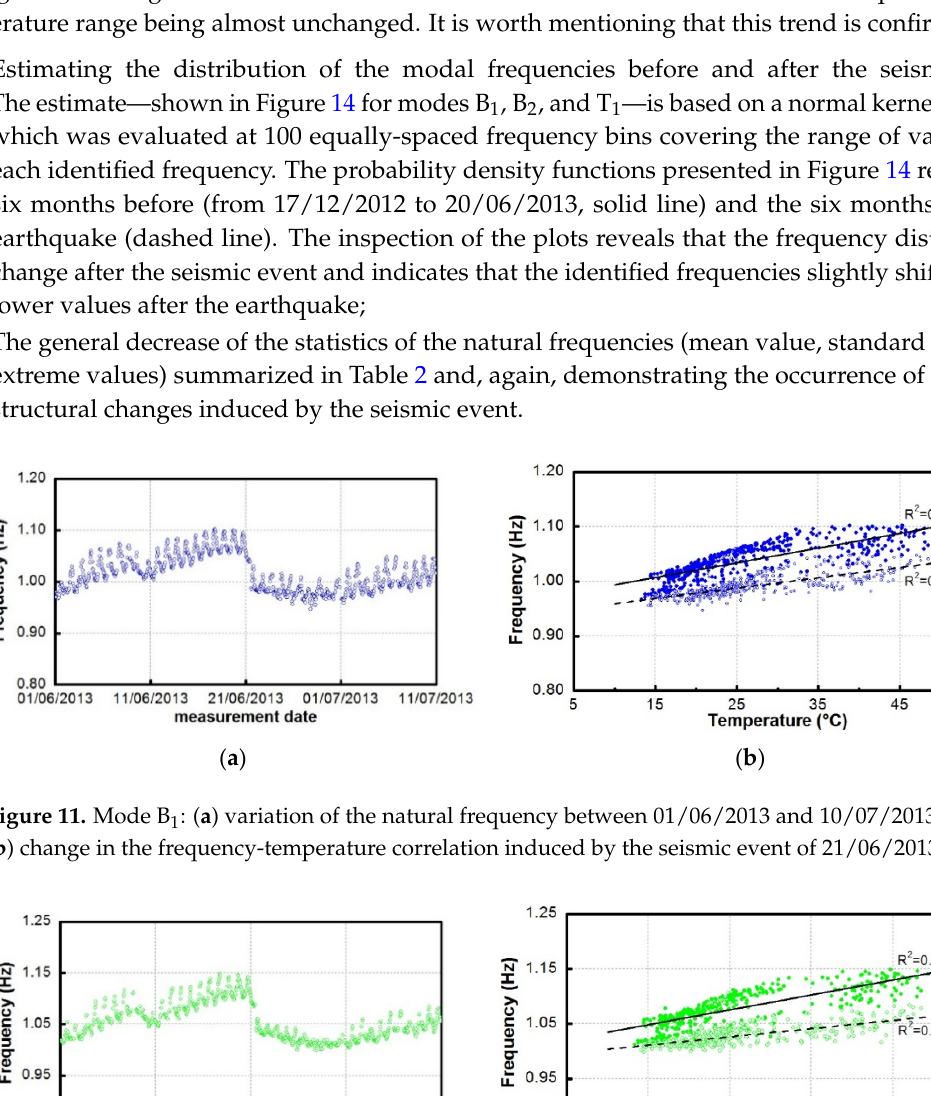
Figure 12. Mode B 2 : ( a ) variation of the natural frequency between 01/06/2013 and 10/07/2013; and ( b ) change in the frequency ‐ temperature correlation induced by the seismic event of 21/06/2013.